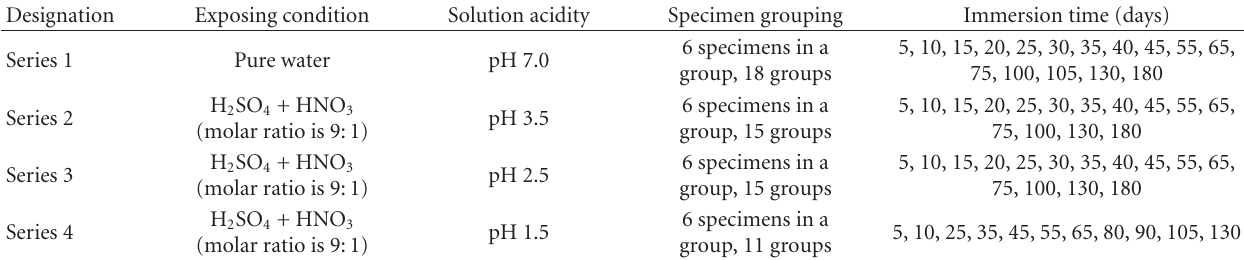
Table 2: Experimental conditions.